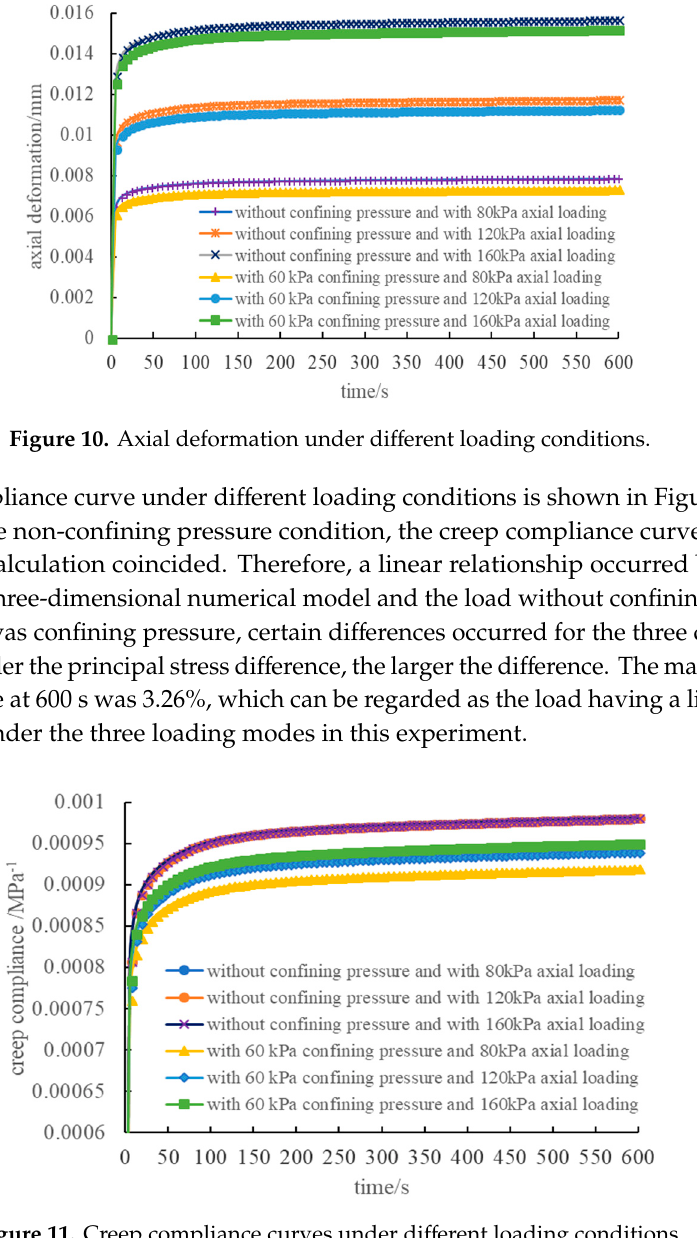
Figure 11. Creep compliance curves under different loading conditions.